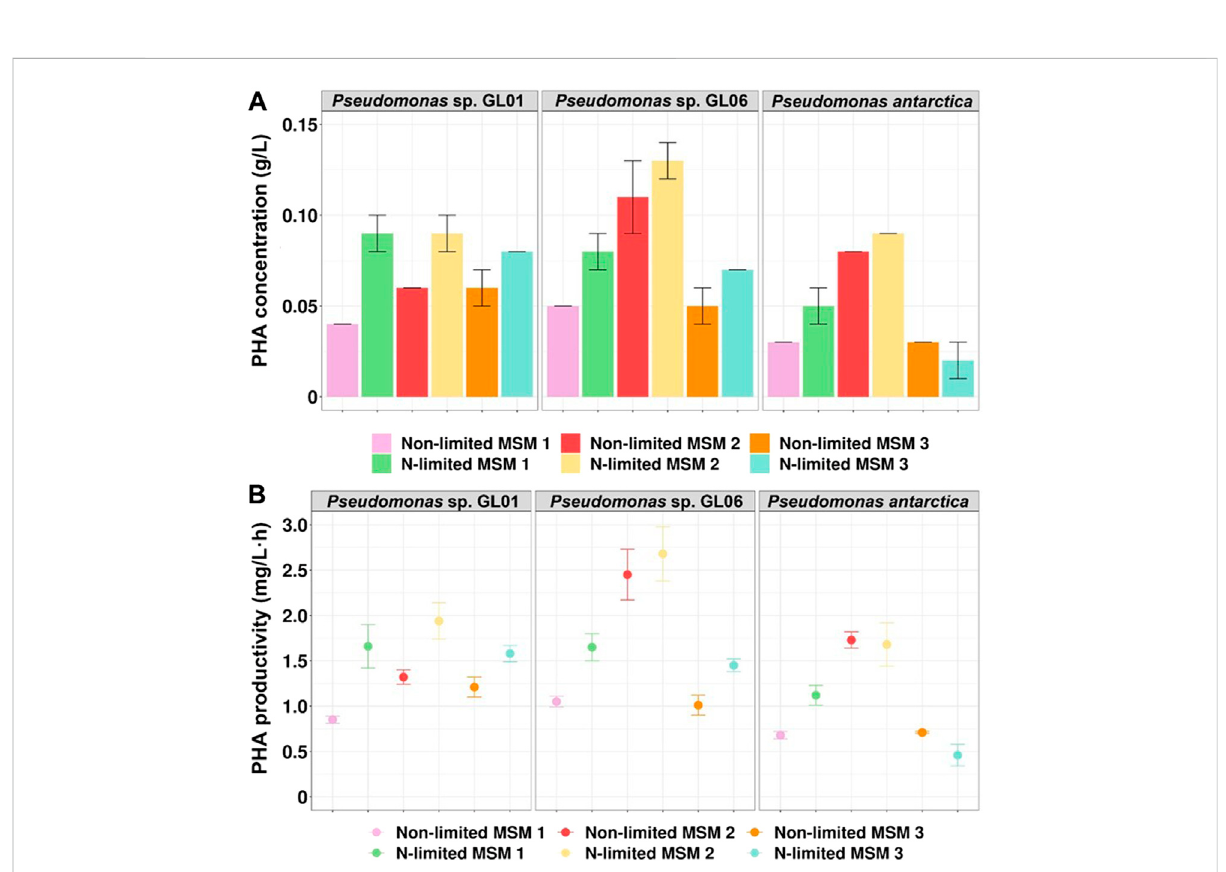
FIGURE 2 PHAproductionfromSMCFA synthetic -richstreamby Pseudomonas sp.GL01, Pseudomonas sp.GL06,and P.antarctica at48 hculturedonthree different growth media (MSM 1, MSM 2, and MSM 3) in shake fl ask experiments under non-limited and N-limited conditions. (A) PHA concentration (g/L) and (B) PHA productivity (mg/L